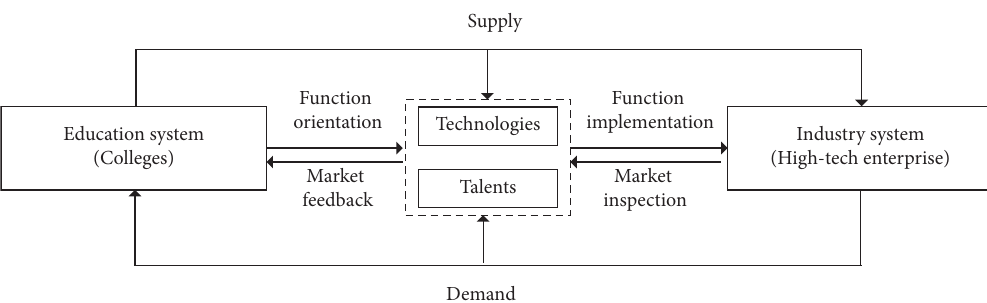
Figure 1: Intrinsic correlation between the education system and industry system in PEI.